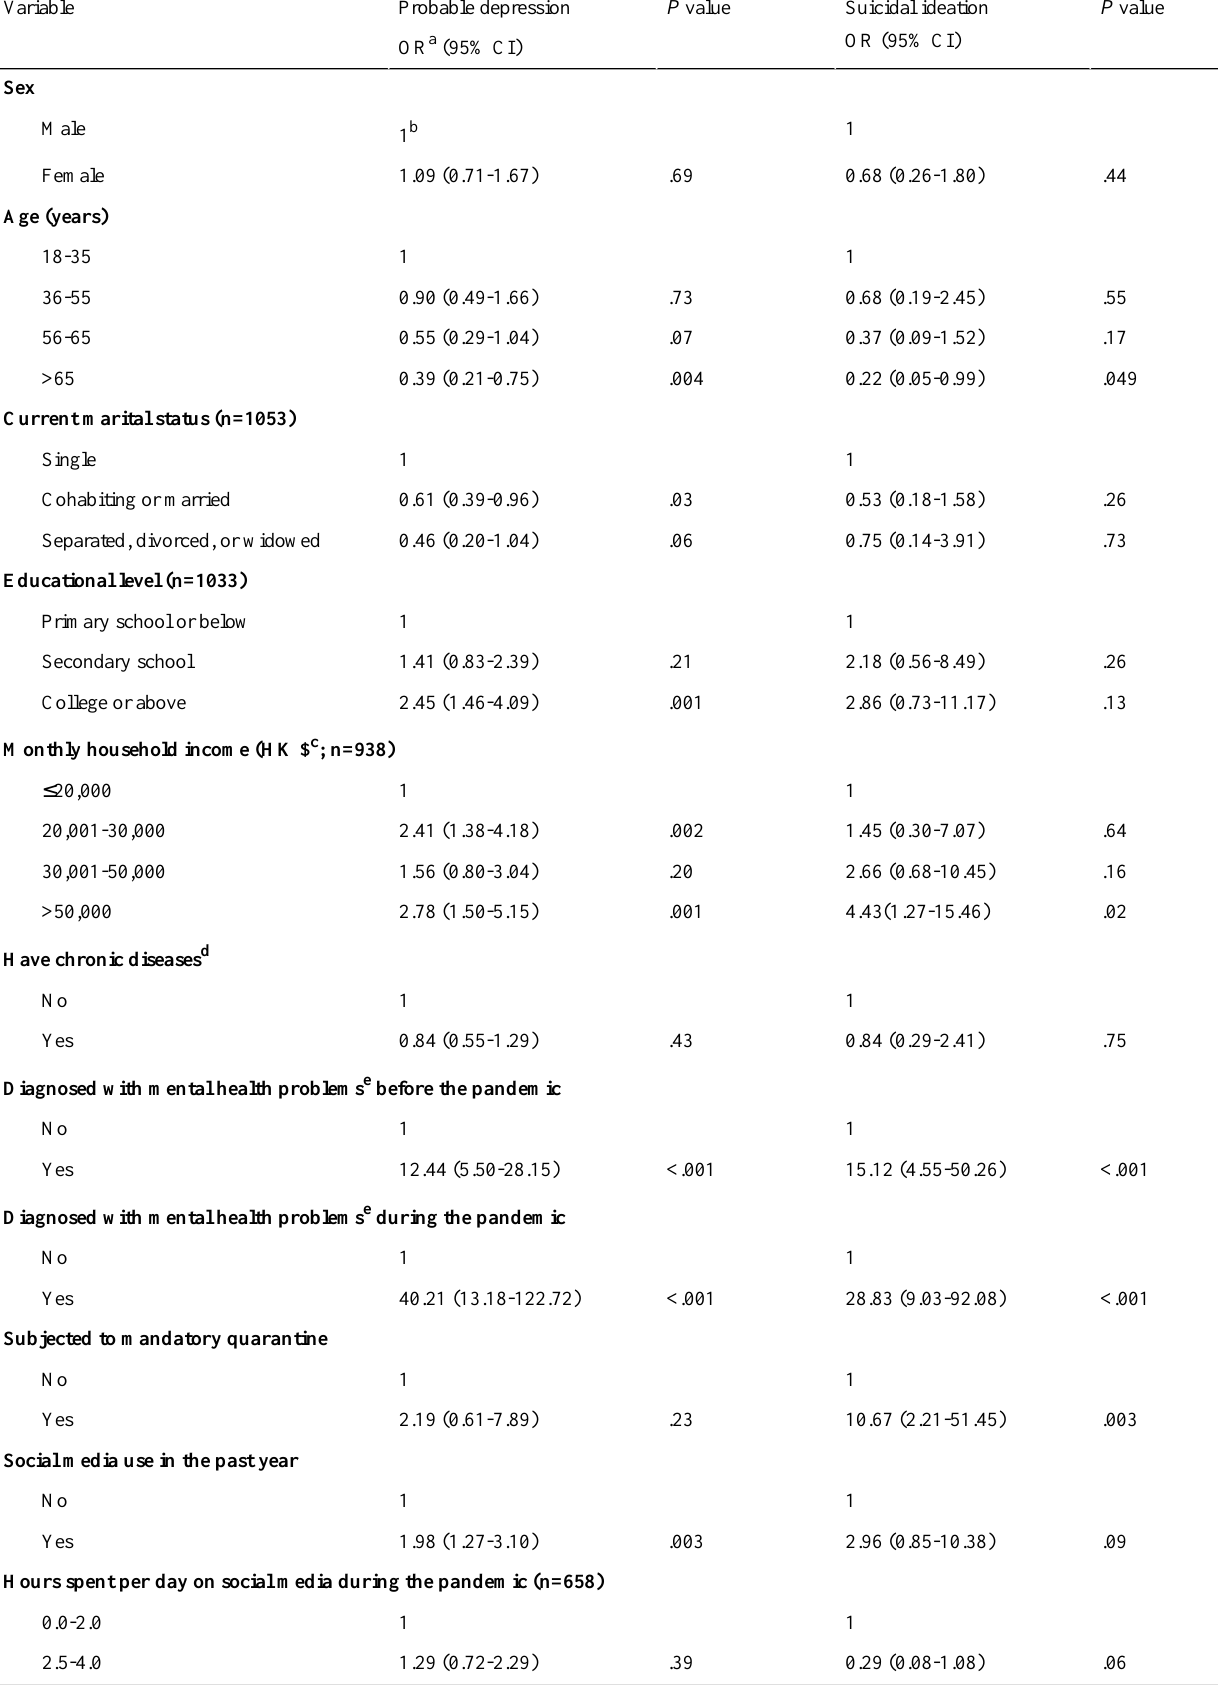
Table 2. Associations between the background or mediator variables and depressive symptoms and suicidal ideation among the adult population in Hong Kong during the COVID-19 pandemic